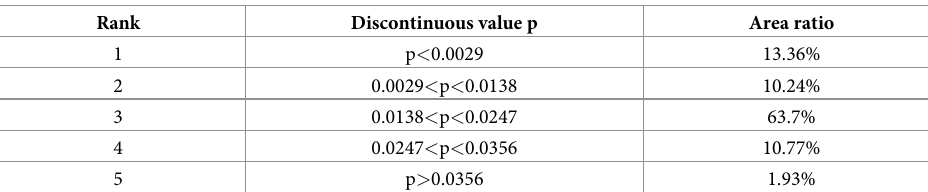
Table 2. Regional